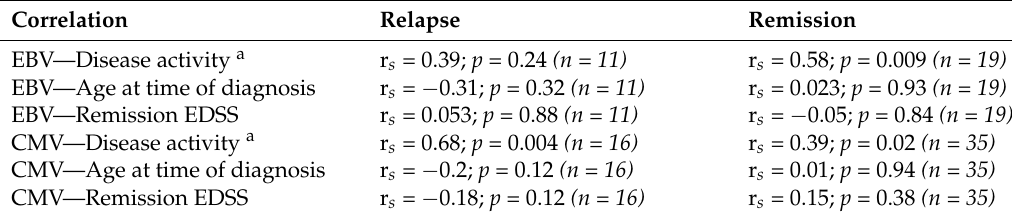
Table 4. Correlation between virus-specific SFU/10 6 PBMC with clinical parameters.